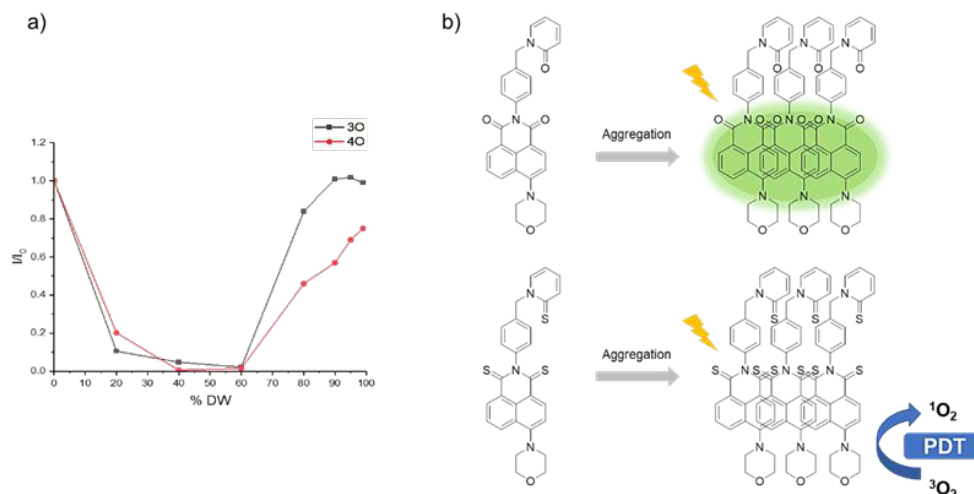
Figure 4. ( a ) Fluorescent emission of 3O and 4O at 508 nm in THF/DW (0–99%); ( b ) proposed scheme of AIE/PDT active fluorescent probes.